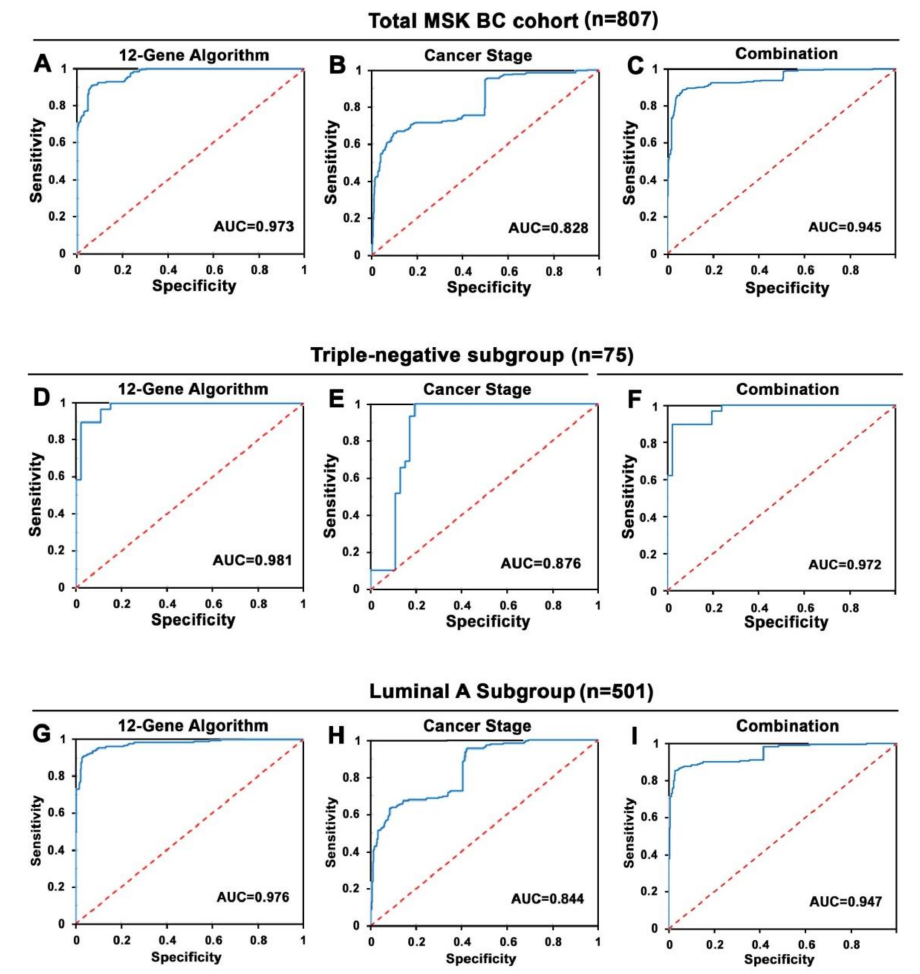
Figure 4. Receiver operating characteristic (ROC) curves of the 12-Gene Algorithm and cancer stage for distinguishing responder and non-responder patients in the MSK Cohort. ( A – C ) ROC curves of the 12-Gene Algorithm in ( A ), cancer stage in ( B ), and their combination in ( C ) in all patients in the MSK Cohort ( n = 807). ( D – F ) ROC curves of the 12-Gene Algorithm in ( D ), cancer stage in ( E ), and their combination in ( F ) in triple-negative patients ( n = 75) in the MSK Cohort. ( G – I ) ROC curves of the 12-Gene Algorithm in ( G ), cancer stage in ( H ), and their combination in ( I ) in luminal A patients ( n = 501) in the MSK Cohort. Areas under the ROC curve (AUC) values are